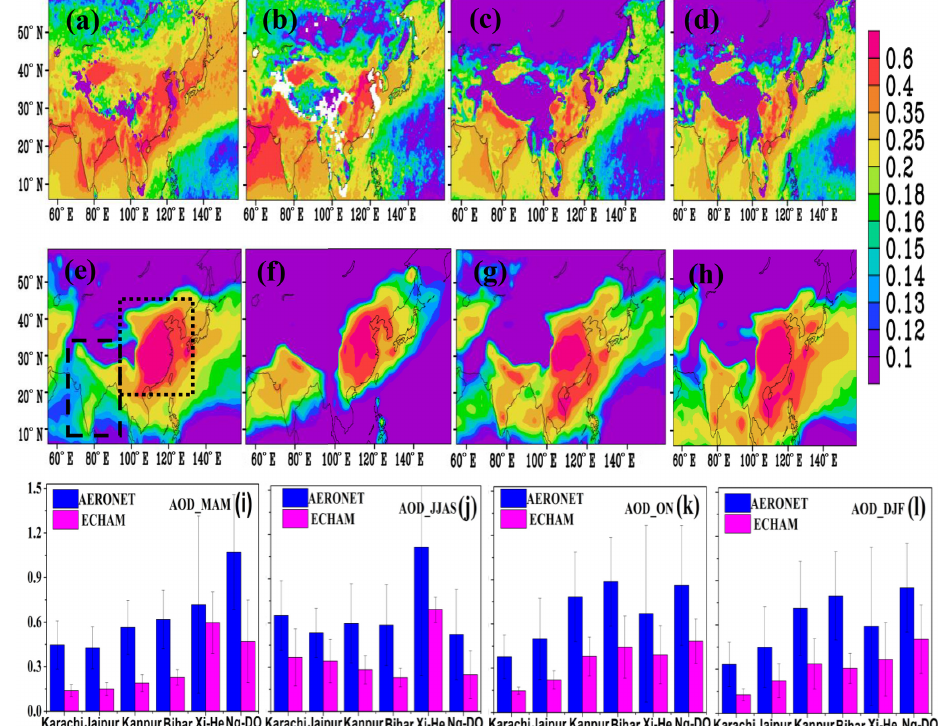
Figure 2. Seasonal mean aerosol optical depth (AOD) from MISR (2000–2016) for the (a) pre-monsoon, (b) summer-monsoon, (c) post- monsoon and (d) winter seasons; (e) – (h) same as (a) – (d) but from CTRL simulations; (i) – (l) same as (a) – (d) but from AERONET (2006– 2016) at the following stations: Karachi, Jaipur, Kanpur, Bihar, Xianghe, Nghia Do. The dashed box in (e) indicates the south Asian region (8–35 ◦ N, 70–95 ◦ E), where SO 2 emissions are enhanced by 48%, and the dotted box indicates Chinese region, where SO 2 emissions are reduced by 70% (20–45 ◦ N, 95–130 ◦